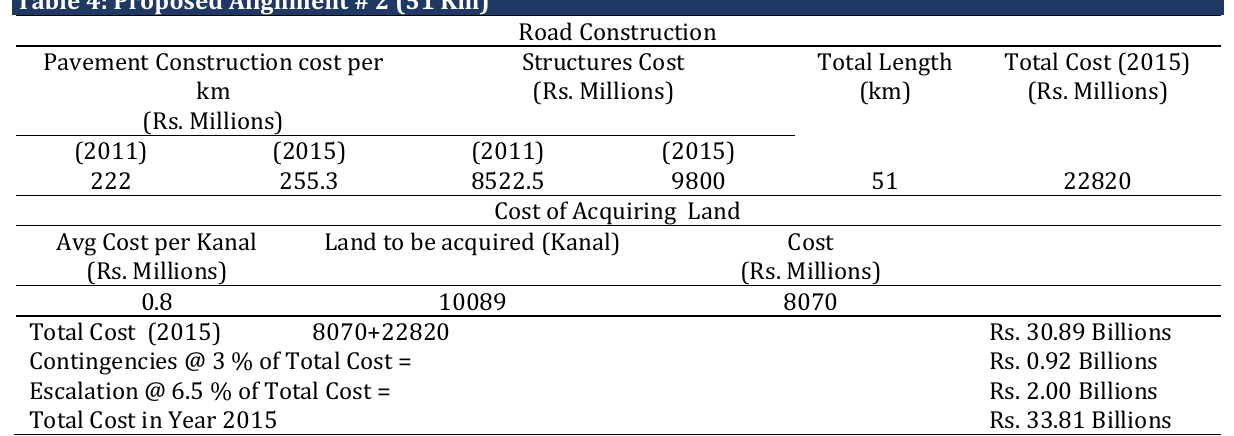
Table 4: Proposed Alignment # 2 (51